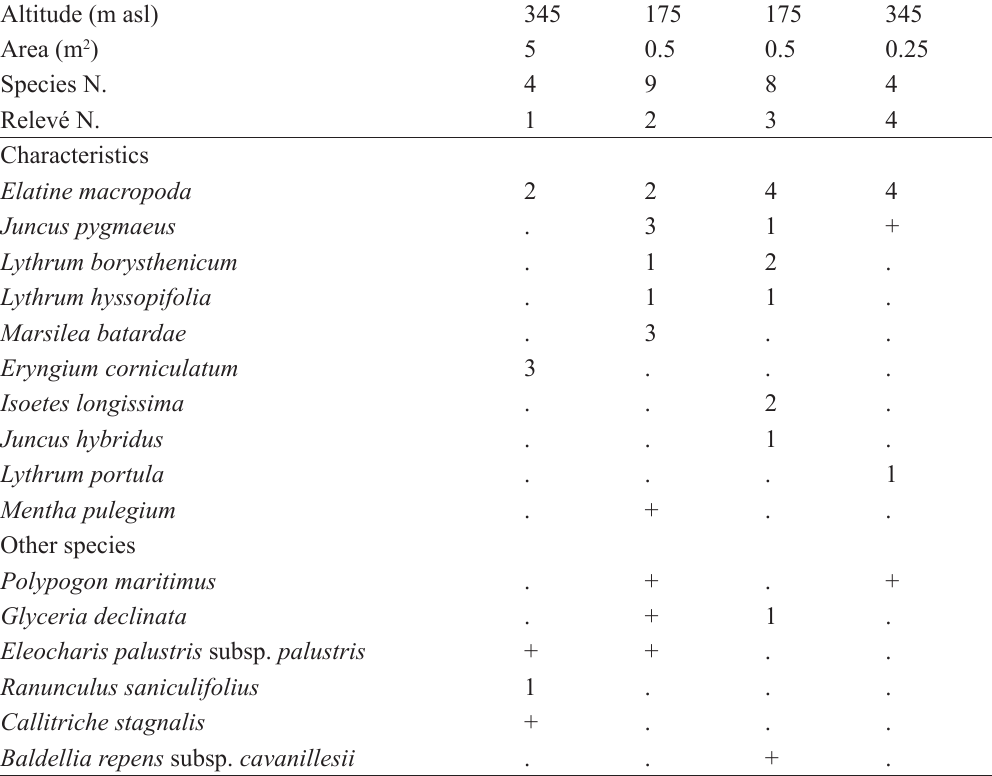
Table 1. Junco pygmaei-Elatinetum macropodae V. Silva, Ribeiro, Pinto-Cruz & J.A. Molina in Vasco et al. ass. nova ( Isoetion , Isoetetalia , Isoeto-Nanojuncetea ) Altitude (m